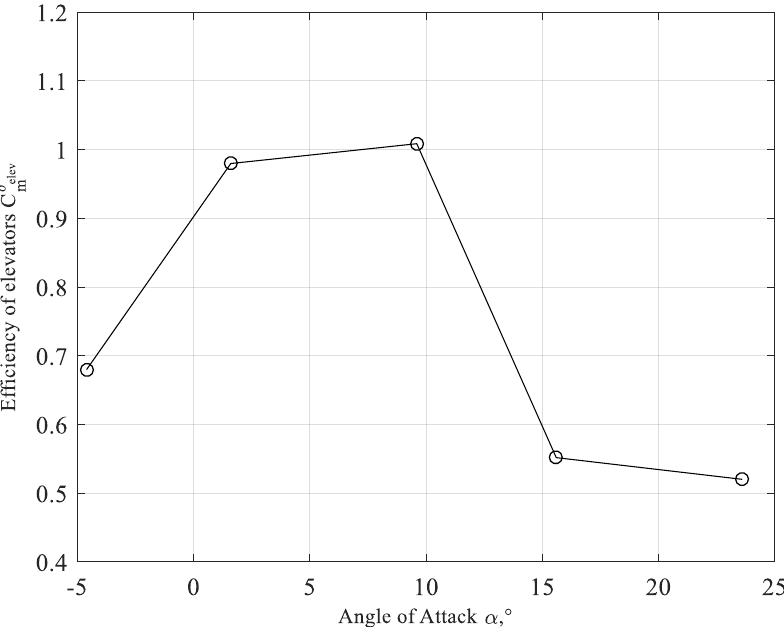
Figure 14 . Elevators’ efficiency (fore and aft elevators are deflected simultaneously). Data taken from [19]